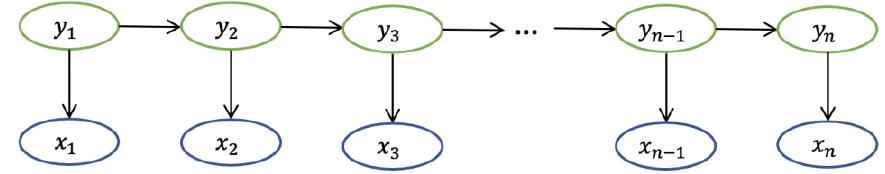
Figure 5. The structure of HMM.